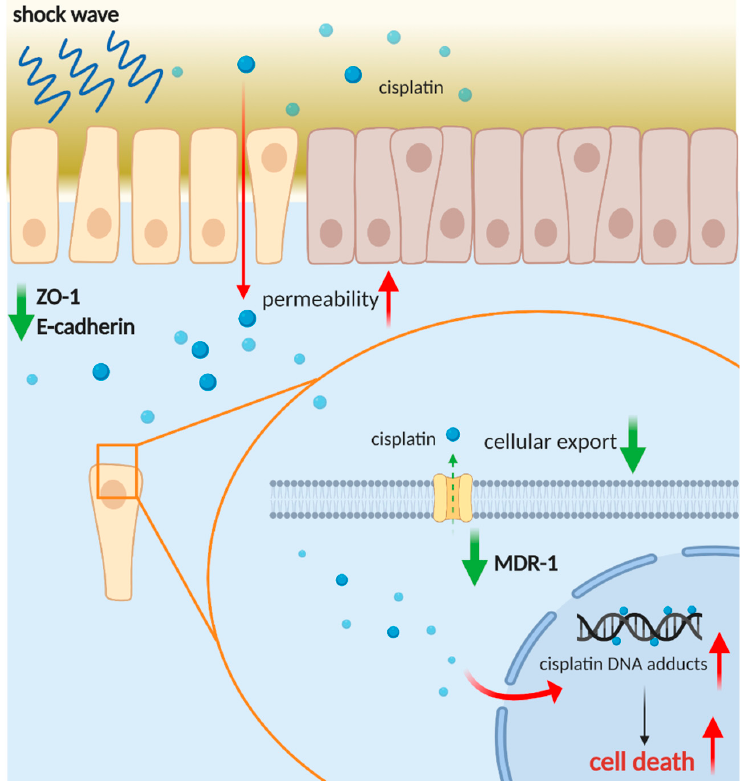
Figure 8. Schematic representation of the role of shock wave treatment in improving infiltration and anticancer effect of cisplatin. Created with https://biorender.com (accessed on 30 March 2021).